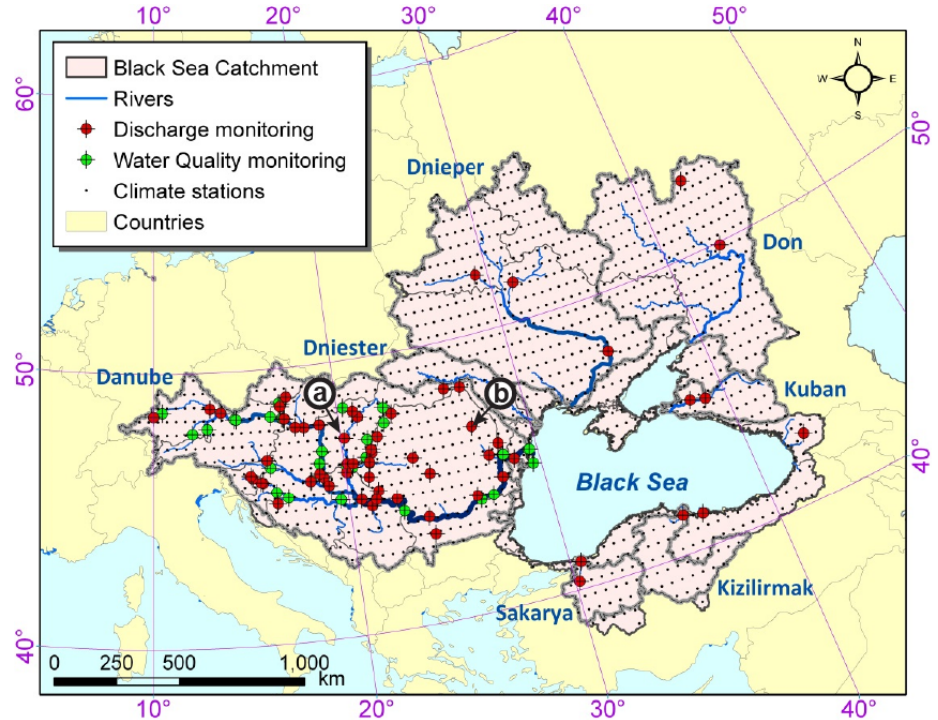
Figure 1. Overview of the Black Sea Catchment depicting major rivers and measured stations of climate, discharge, and nitrate. The labeled points a and b correspond to the labeled points in Figure 4.